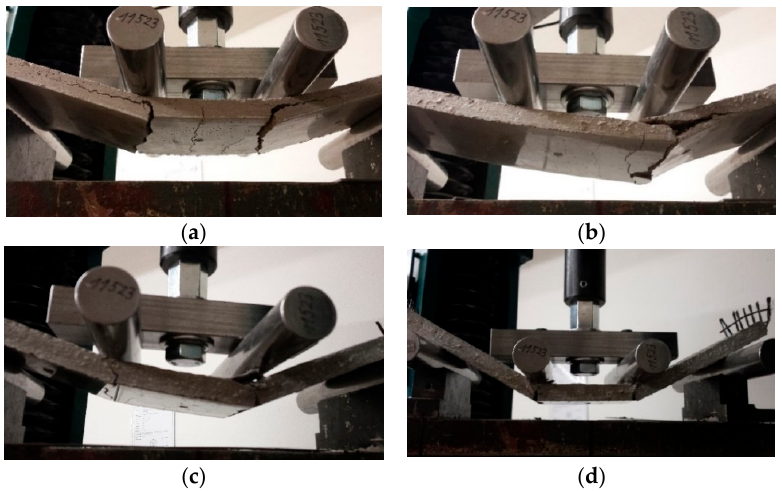
Figure 11. Failure modes of the textile reinforced specimens: ( a ) one textile layer reinforced specimens without BF addition; ( b ) three textile layer reinforced specimens without BF addition; ( c ) one textile layer reinforced specimens containing 5% BF; ( d ) one textile layer reinforced specimens containing 7.5% BF.